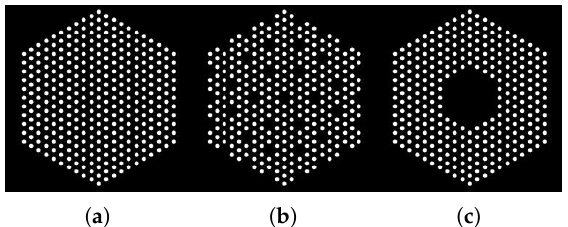
Figure 1. Examples of binary masks of the simulated fuel assemblies. ( a ) Case “1”, ( b ) Case “2”, and ( c ) Case “3”. In Case “1”, the mock-up fuel assembly hosted 331 60 Co pins of 8.879 g/cm 3 density, which emitted 1.17 and 1.33 MeV gamma rays. In Cases “2” and “3”, 10% 60 Co pins pins were removed at the center or